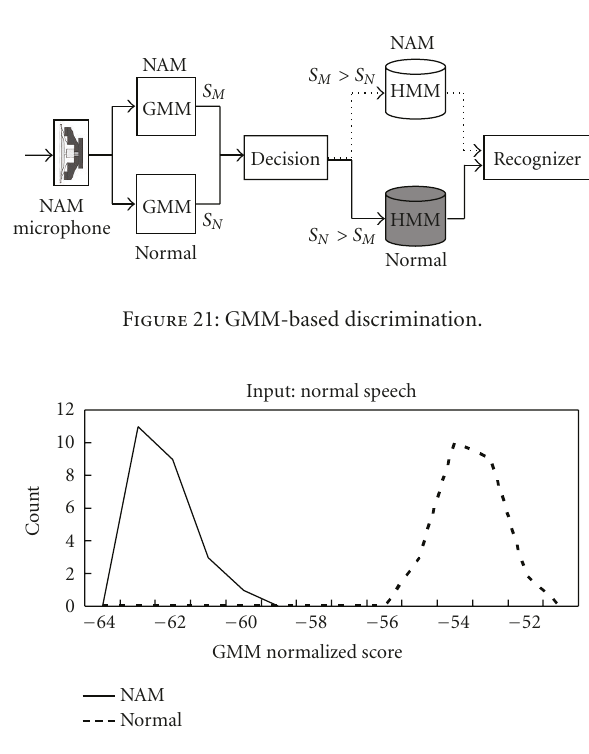
Figure 22: GMM normalized scores—input normal speech.